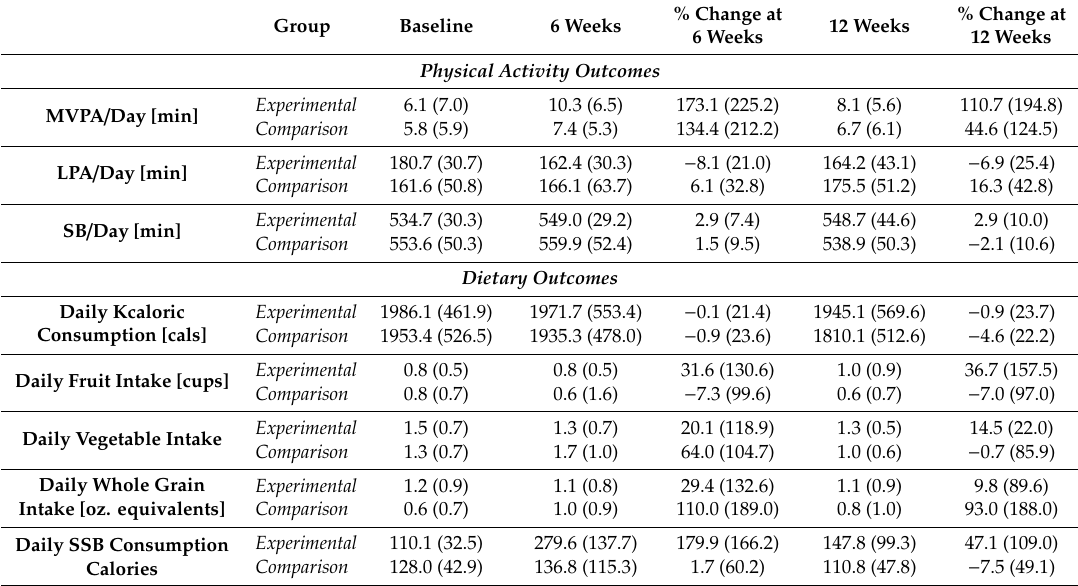
Table 3. Physical Activity and Dietary Outcomes by Group at Baseline, 6 Weeks, and 12